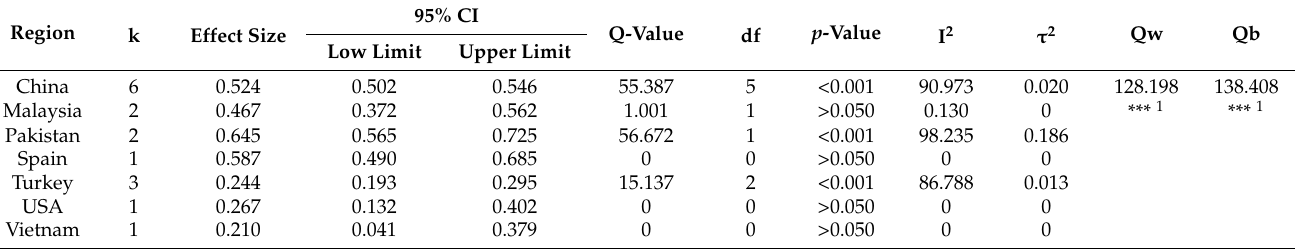
Table 7. Moderating effect